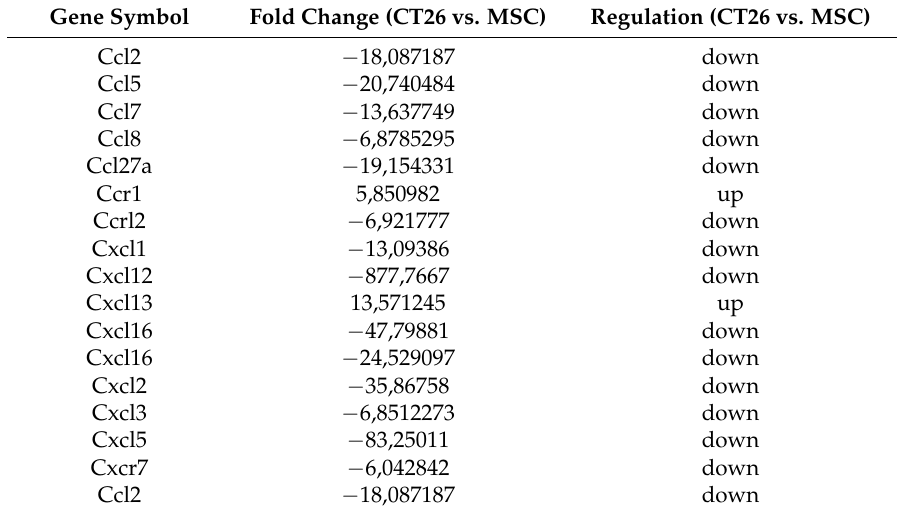
Table 1. Comparison of gene expression patterns of chemokine and chemokine receptors obtained by DNA microarray on CT26 and MSCs.